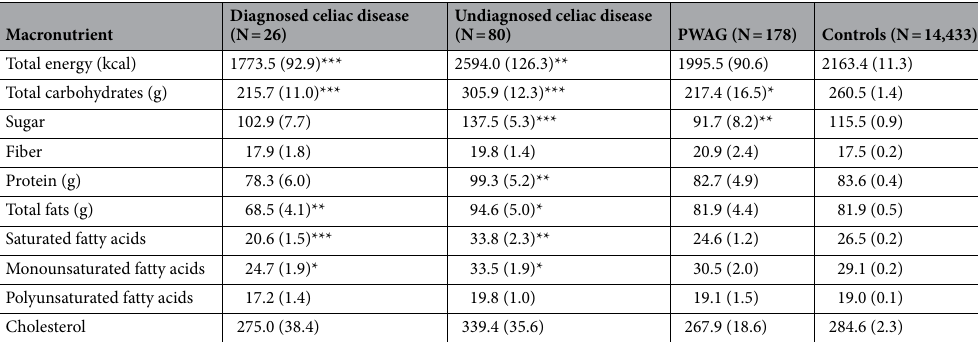
Table 2. Adjusted a mean (SE) macronutrient intake from food among NHANES participants 20 years and older with and without celiac disease and PWAG, United States, 2009–2014. NHANES, National Health and Nutrition Examination Survey; PWAG, persons without celiac disease avoiding gluten; SE, standard error. a Adjusted for age, sex, and race/ethnicity. *p < 0.05, **p < 0.01, and ***p < 0.001 compared to controls.